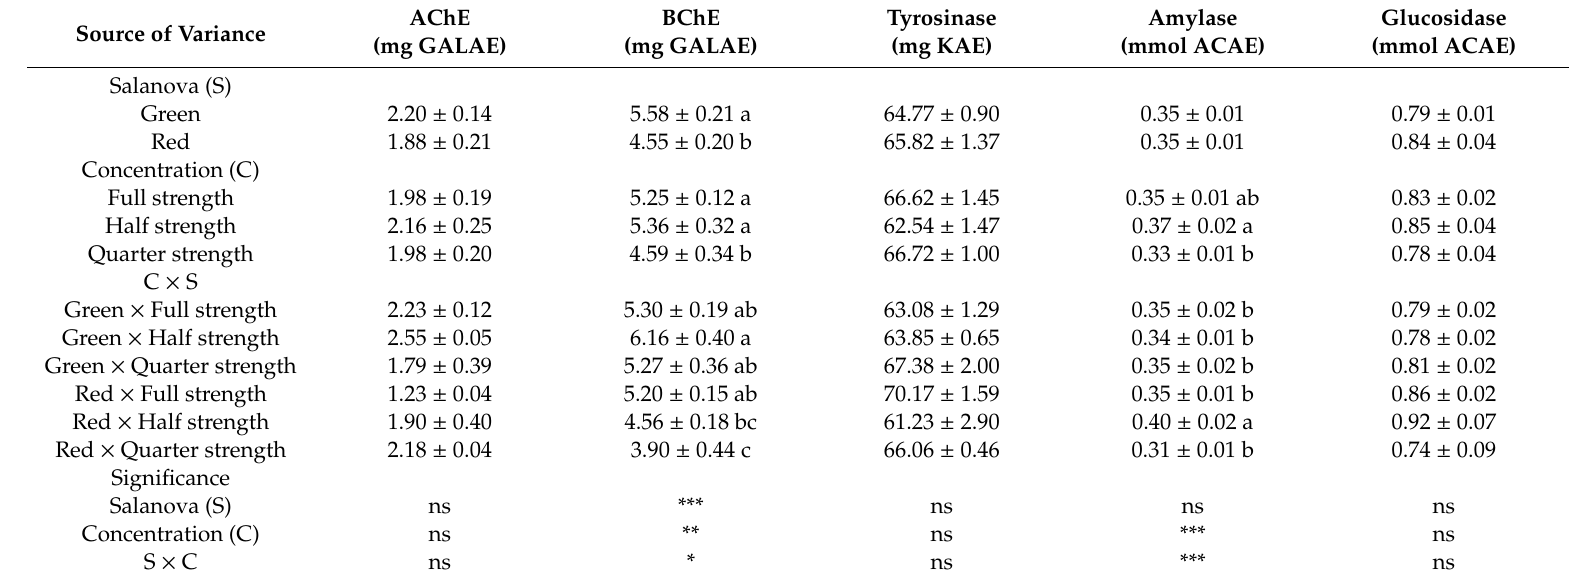
Table 3. Enzyme inhibitory activities in green and red Salanova lettuce (S) in nutrient solutions with di ff erent macrocations concentration (C). AChE, acetylcholinesterase, BChE, butyrylcholinesterase, GALAE, galantamine equivalents, KAE, kojic acid equivalents, ACAE, acarbose